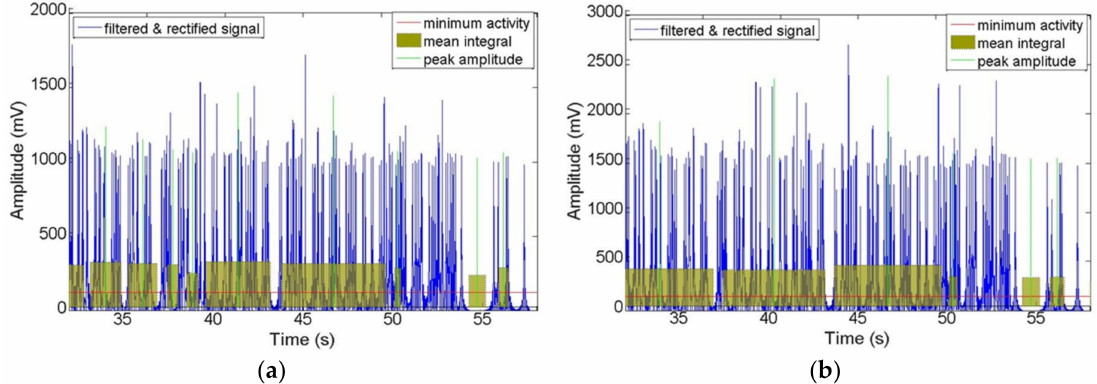
Figure 10. Recorded EMG signals at left and right sides of gluteus medius muscle locations during walking motion: ( a ) Left side; ( b ) Right side.